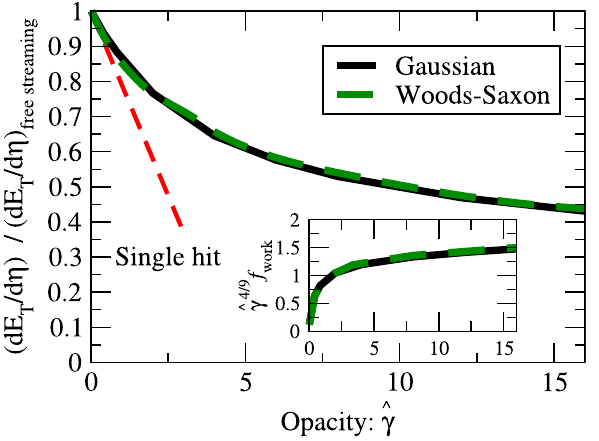
Fig. 4 The fractional work (26) done during the kinetic theory evo- lution as a function of ˆ γ . Numerical results for two different initial transverse profiles are compared with the perturbative O ( ˆ γ) -result of [73] (red